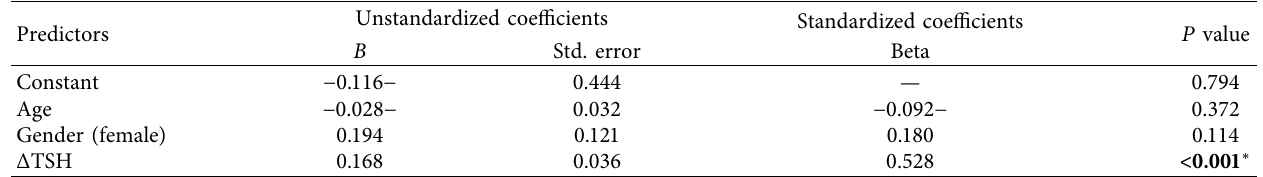
Table 4: Multivariable linear regression analysis of determinants of change in BMI among